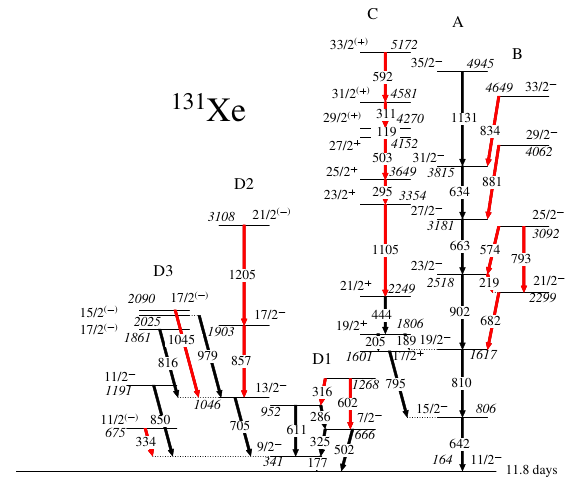
Figure 1. Partial level scheme of 131 Xe as obtained in the present work. New γ ray transitions are marked with red colour.